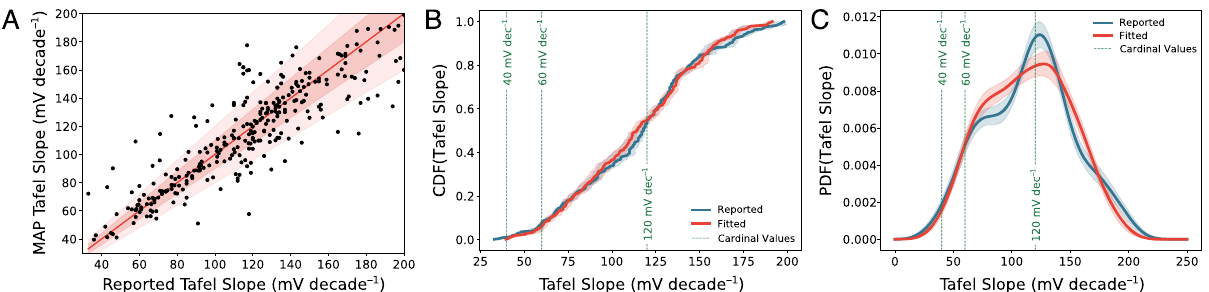
Fig. 3 Unbiased re fi t of literature data using our Bayesian analysis approach reveals little preference for cardinal values of the Tafel slope for CO 2 reduction catalysts. A Correlation plot of reported Tafel slopes from the literature against MAP Tafel slopes fi tted by our algorithm on identical data. The solid red line represents a perfect agreement, while the red fi lled intervals are lines representing 10% and 20% relative error. B Cumulative distribution function of the Tafel slopes reported in literature data (blue), and those re fi tted by our algorithm (red). Error intervals correspond to one standard deviation of bootstrapped resamples. C Kernel density estimates (KDEs) of the empirical probability distribution function of Tafel slopes reported in literature data (blue) and MAP Tafel slopes re fi tted by our algorithm (red). Error intervals correspond to one standard deviation of bootstrapped resamples. Green dashed lines in both ( B , C ) correspond to cardinal values of the Tafel slope predicted by